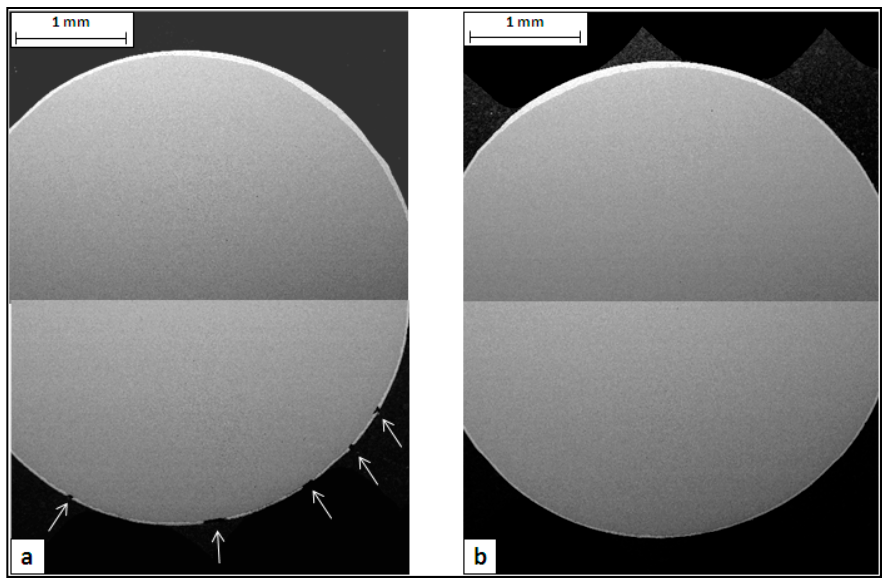
Figure 4. SEM images of wire cross sections after the torsion test: ( a ) Steel 1 and ( b ) Steel